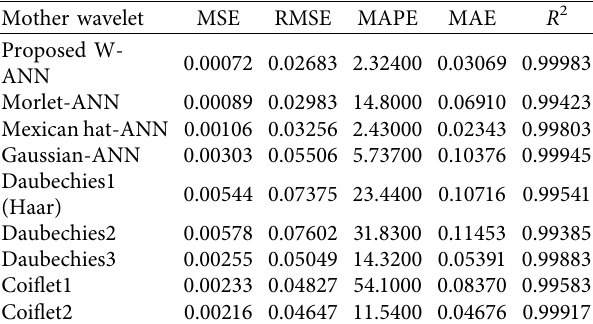
Table 2: Comparison of the wavelet-ANN. Mother wavelet MSE RMSE